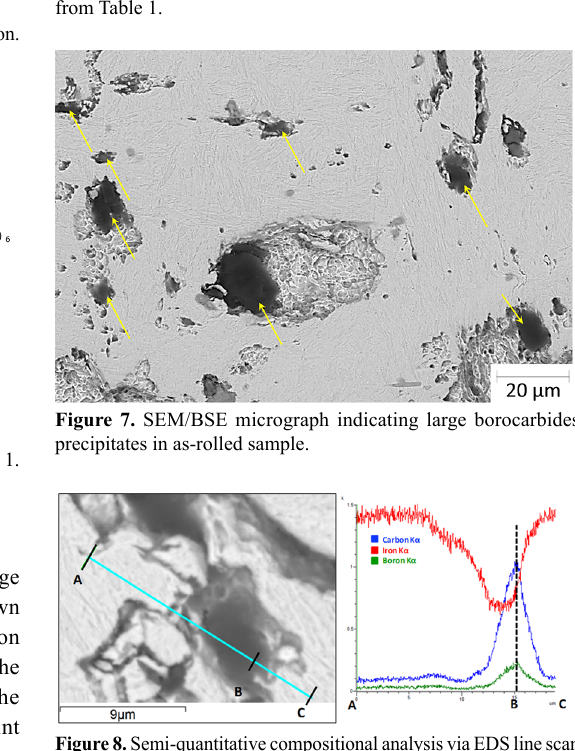
In order to evaluate effect of tempering